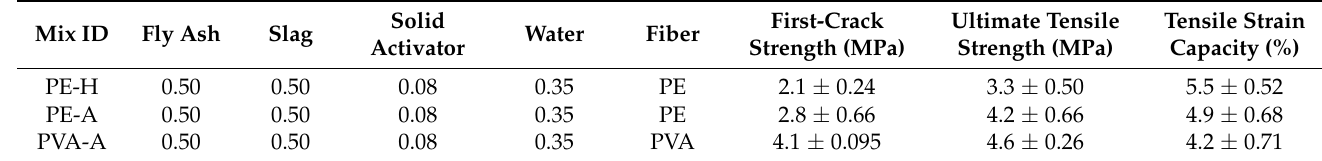
Table 3. Typical coordination ratio and test results of the FOPG. Adapted with permission from [67], copyright 2017